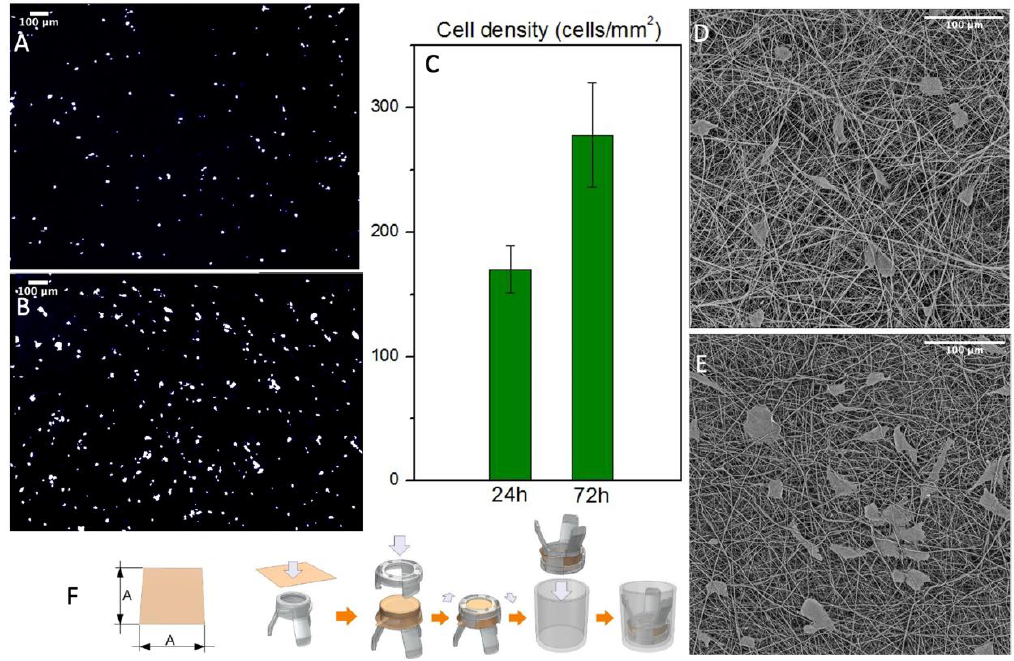
Figure 7. ( A , B ) NHDF nuclei when stained with DAPI after 24 and 72 h respectively ( C ) Cell density count with ImageJ of the stained nuclei ( n = 3) ( D , E ) SEM micrographs of the cultured scaffold after 24 and 72 h respectively ( F ) Mounting process of the scaffolds on Scaffedex supports. The presence of certain materials can negatively affect red blood cells and destroy their cell membrane causing the release of haemoglobin into the solution. [32] Haemolysis rate was measured using colorimetric assay of released haemoglobin from red blood cells. The lowest degree of haemolysis, absorbance of 0.042 ± 0.0012, was provoked by negative controls containing PBS with the addition of diluted whole blood. The highest